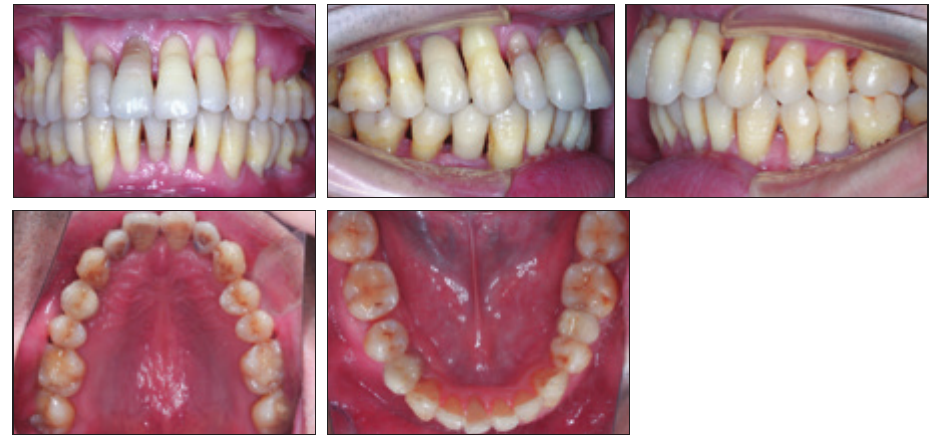
Figure 11. 18-month post-treatment intraoral